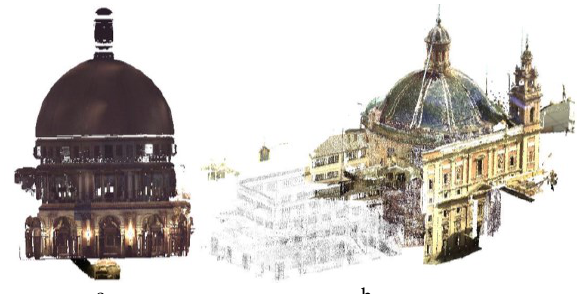
Figure 5. Aligned scans: a) view from inside; b) view from